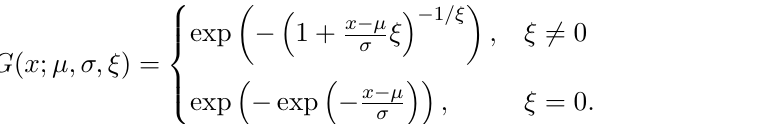
Figure 5 . Universal scaling in the tails of the vortex number distribution. The cumulative prob- abilities P ( n ≤ r ) (Left) and P ( n ≥ r ) (Right) are shown as functions of the quench rate τ Q . The analytical results (solid lines) for the EP distribution are shown in the range of quench times from τ Q = 800 to τ Q = 4000 , where the numerical simulations exhibit Kibble-Zurek scaling. alized extreme value (GEV)